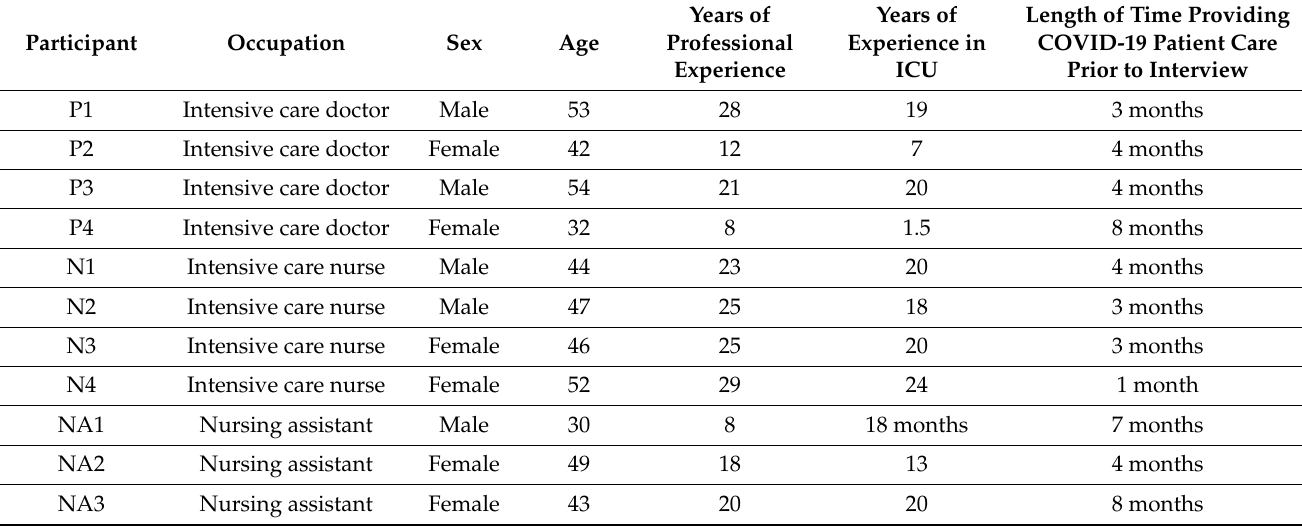
Table 5. Demographic and occupational profiles of interviewees.